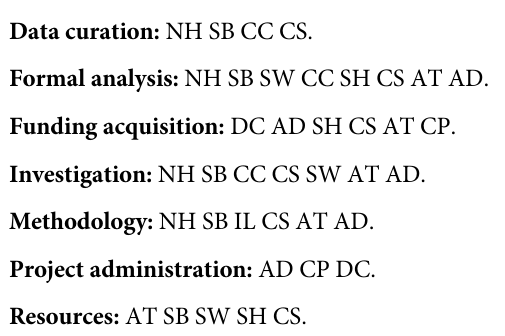
S2 Fig. Effect of commercial recombinant H5 haemagglutinin on mRNA expression of IL- 6 and CXCL8. Fold change in mRNA expression level of IL-6 (A) and CXCL8 (B) in 16HBE14o- cells treated for 3 hr with commercial recombinant H5 hemagglutinins,